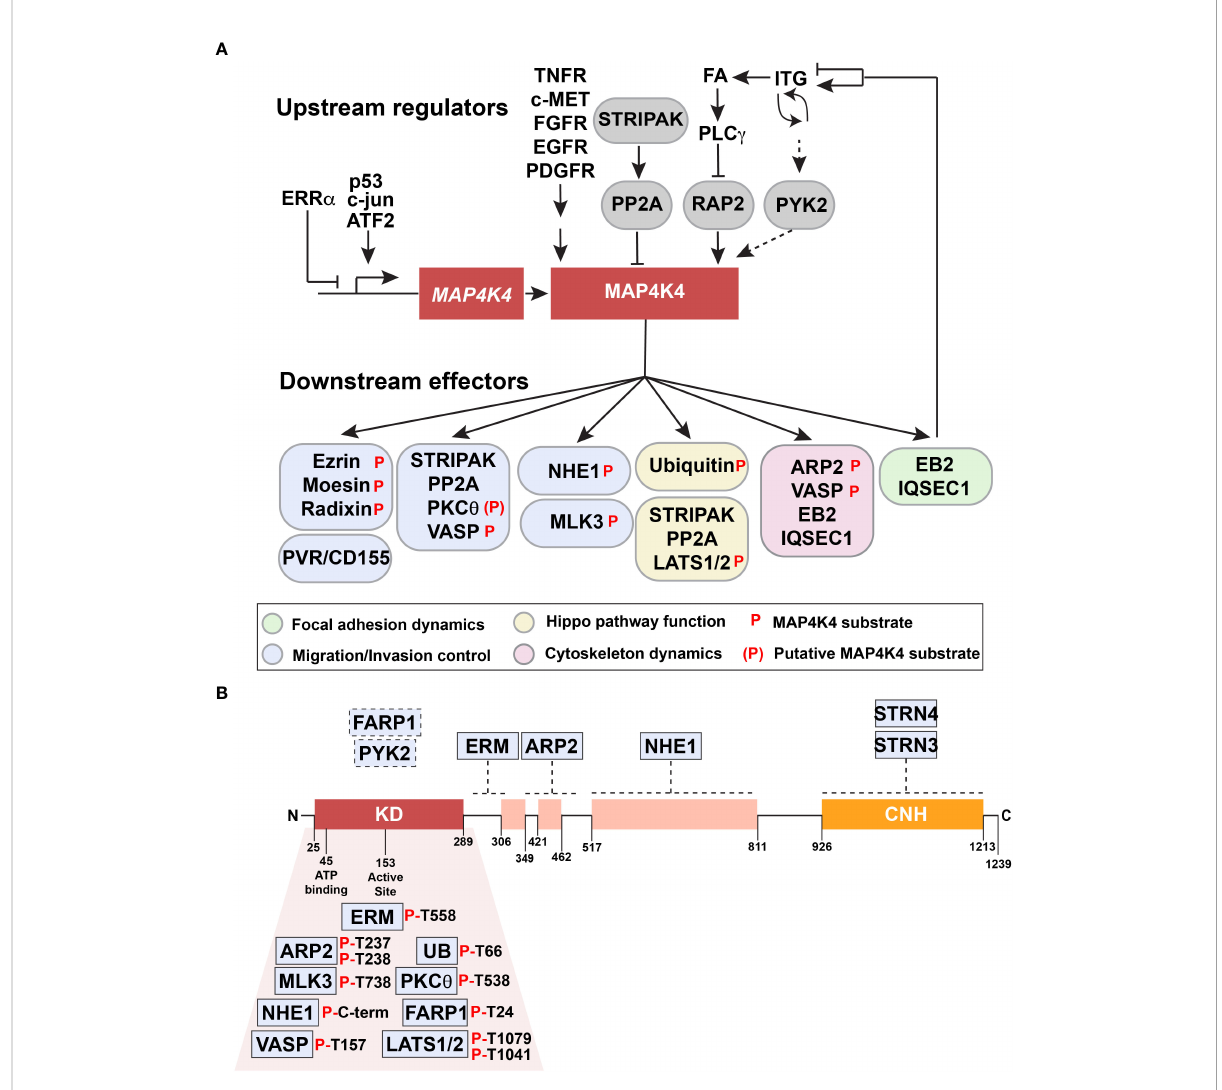
FIGURE 3 Upstream regulators and downstream effectors of MAP4K4. (A) Upstream regulators and downstream effectors of MAP4K4 are shown. Solid arrows or capped lines indicate experimentally established regulation, dotted arrows indicate potential regulatory mechanism. (B) Proteins indicated in boxes above the structure of MAP4K4 are experimentally con fi rmed interactors of MAP4K4. Dotted lines indicate approximate binding regions on MAP4K4. Proteins indicated below the kinase domain are experimentally validated substrates of MAP4K4. Residues phosphorylated by MAP4K4 are